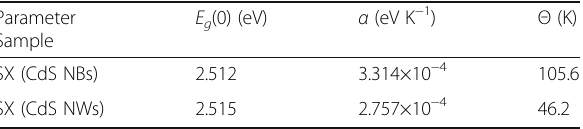
Table 1 The fitting parameters for CdS NBs and NWs samples Parameter Sample